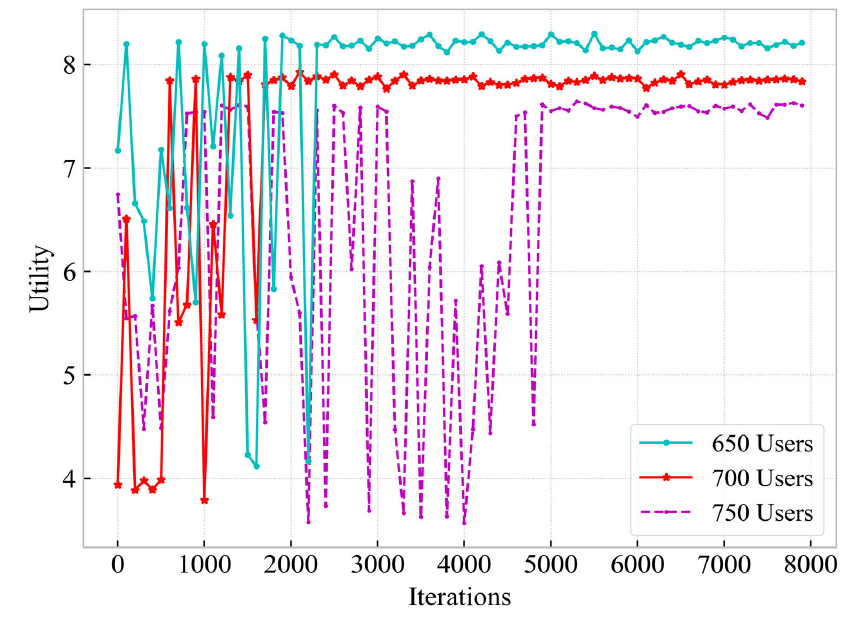
Figure 10. The comparison of system utility under different numbers of users.